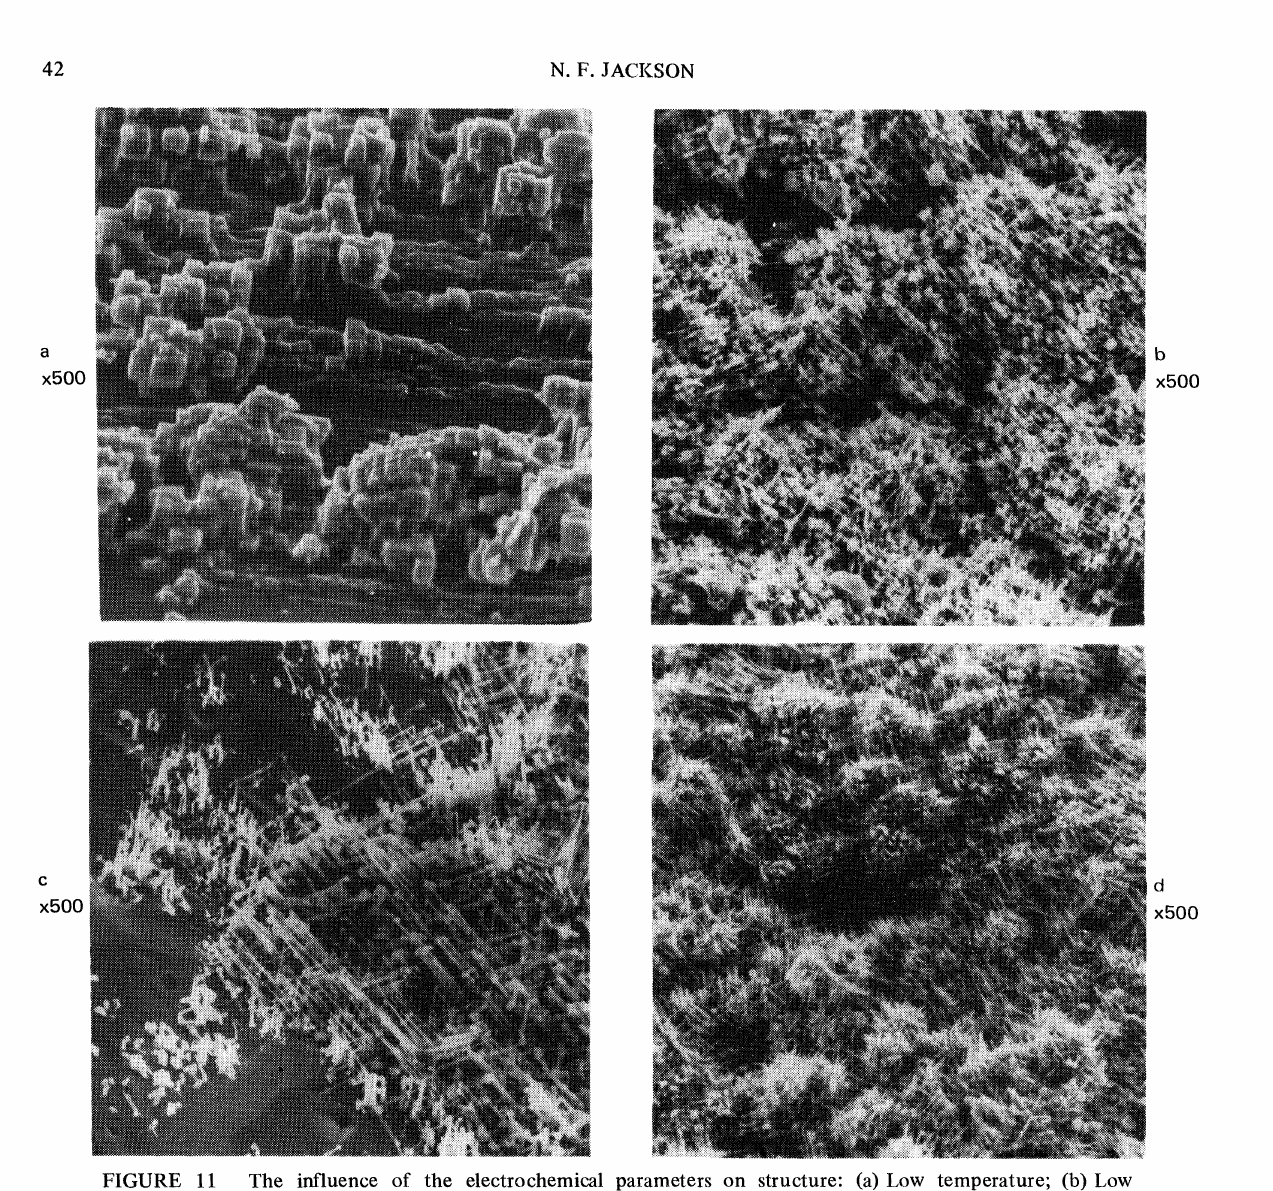
FIGURE 11 The influence of the electrochemical parameters on structure: (a)Low temperature; (b)Low concentration; (c) Low current density; (d) High temperature, concentration and current